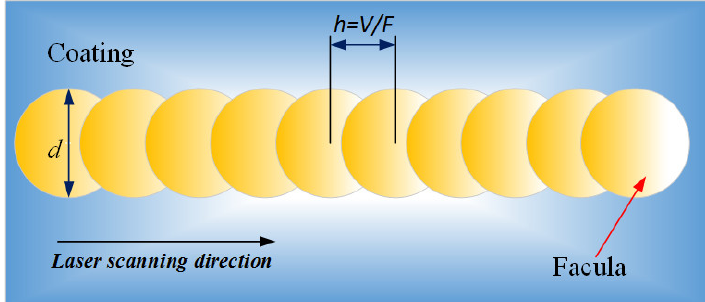
Figure 9. Diagram of laser spot overlap.